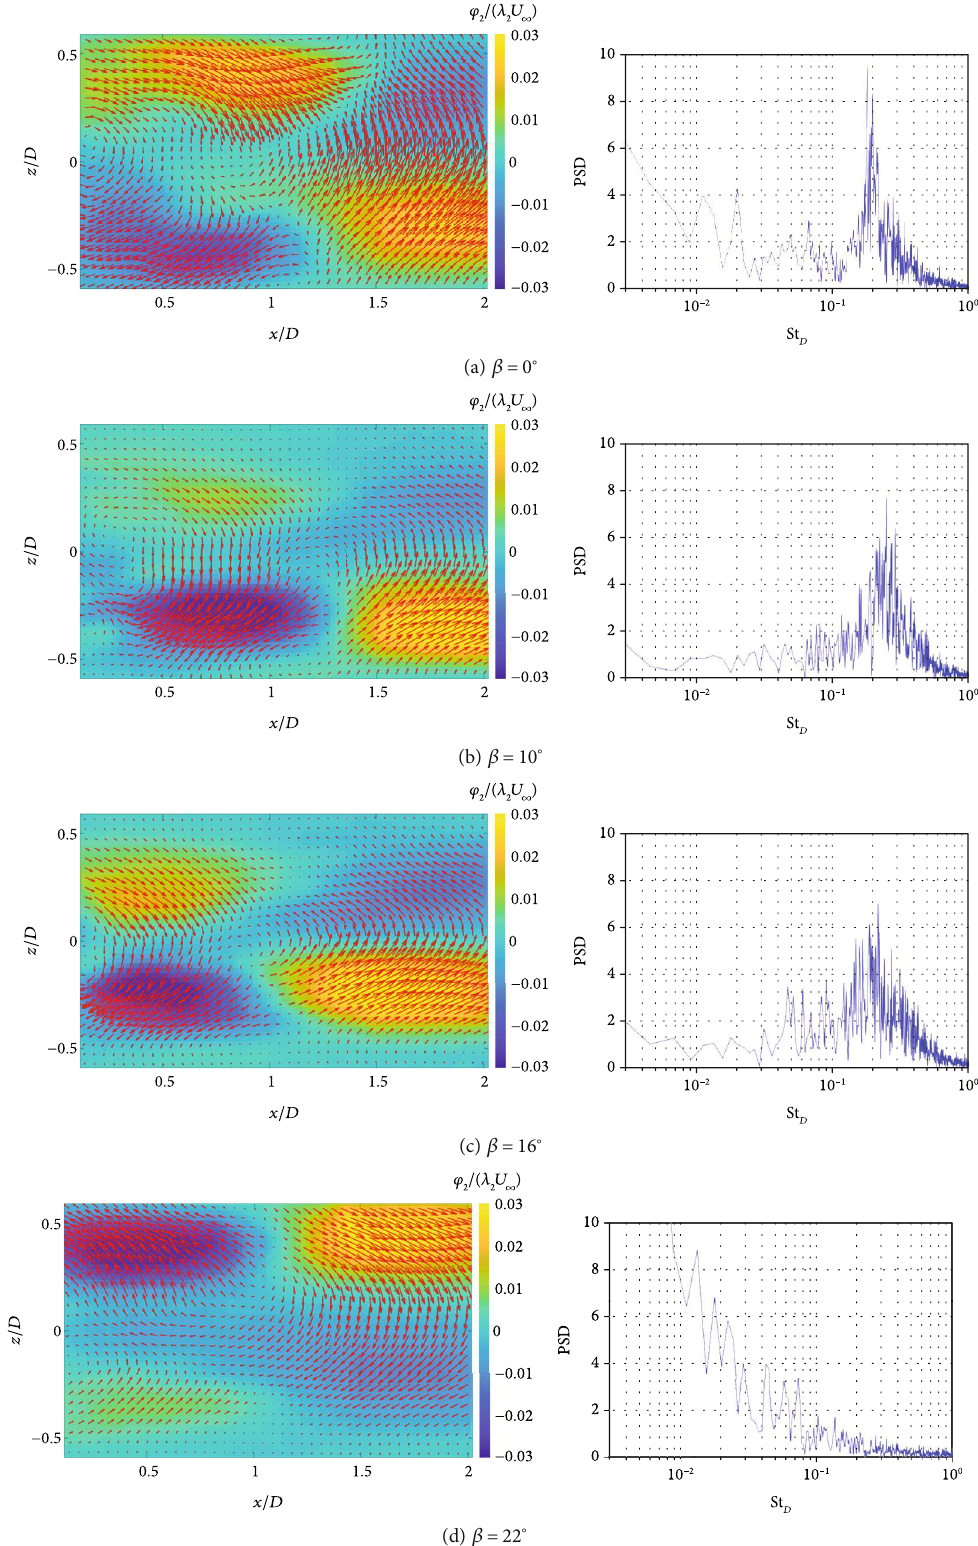
Figure 17: Spatial distribution of the second POD mode at (a) β = 0 ° , (b) β = 10 ° , (c) β = 16 ° and (d) β = 22 °